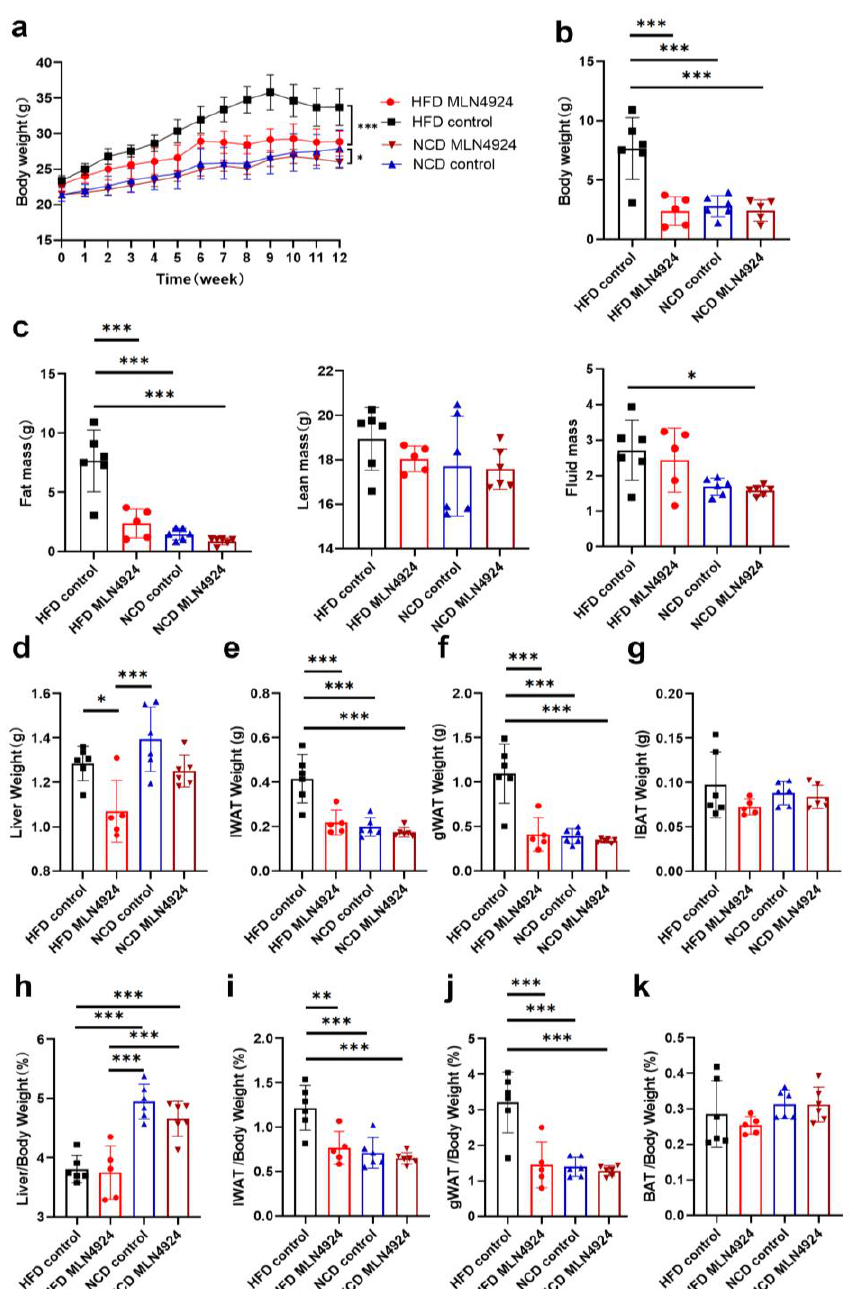
Figure 3. MLN4924 ameliorates fatty liver and obesity in mice. ( a ) Mice were divided into four groups: NCD Control mice, NCD MLN4924 mice, HFD Control mice, and HFD MLN4924 mice. All mice were weighed every week and the body weights (mean ± SD) are plotted as a function of time ( n = 5 – 6 per group). ( b ) The body weight differences analysis of mice from four groups at the 12-week feeding endpoint ( n = 5 – 6 per group). ( c ) Body composition analysis using MRI for four groups ( n = 5 – 6 per group). ( d – g ) The weight of liver, iWAT, gWAT and BAT in mice of four groups were plotted. ( h – k ) The liver, iWAT, and gWAT and BAT weight percentage of body weight in mice from four groups were plotted ( n = 5 – 6 per group). Data represents the mean ± SD, n ≥ 3. Two -way ANOVA was used for body weight analysis and one-way ANOVA was used for comparison among groups (* p < 0.05, ** p < 0.01, *** p < 0.001). After 12 weeks of feeding, fat mass, lean mass and fluid mass of the mice from all four groups were measured by the animal NMR analyzer. The average fat mass of mice